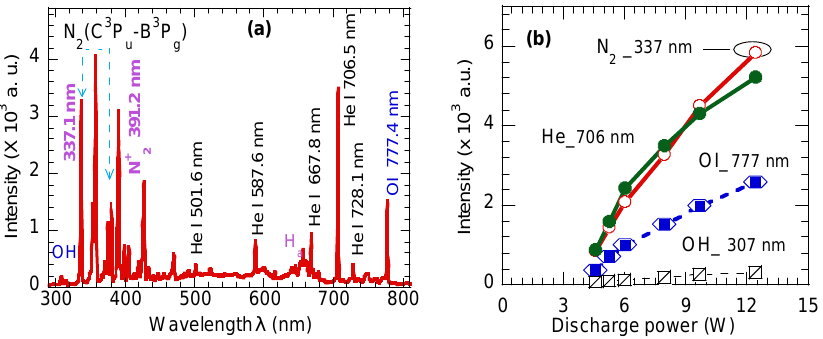
Figure 3. ( a ) Optical emission spectra of atmospheric pressure He-H 2 O plasma jet during treatment of polyimide at a fixed flow rate of 10 L/min; ( b ) Peak emission intensities of N 2 337, He 706 and OI 777 nm dependences of discharge